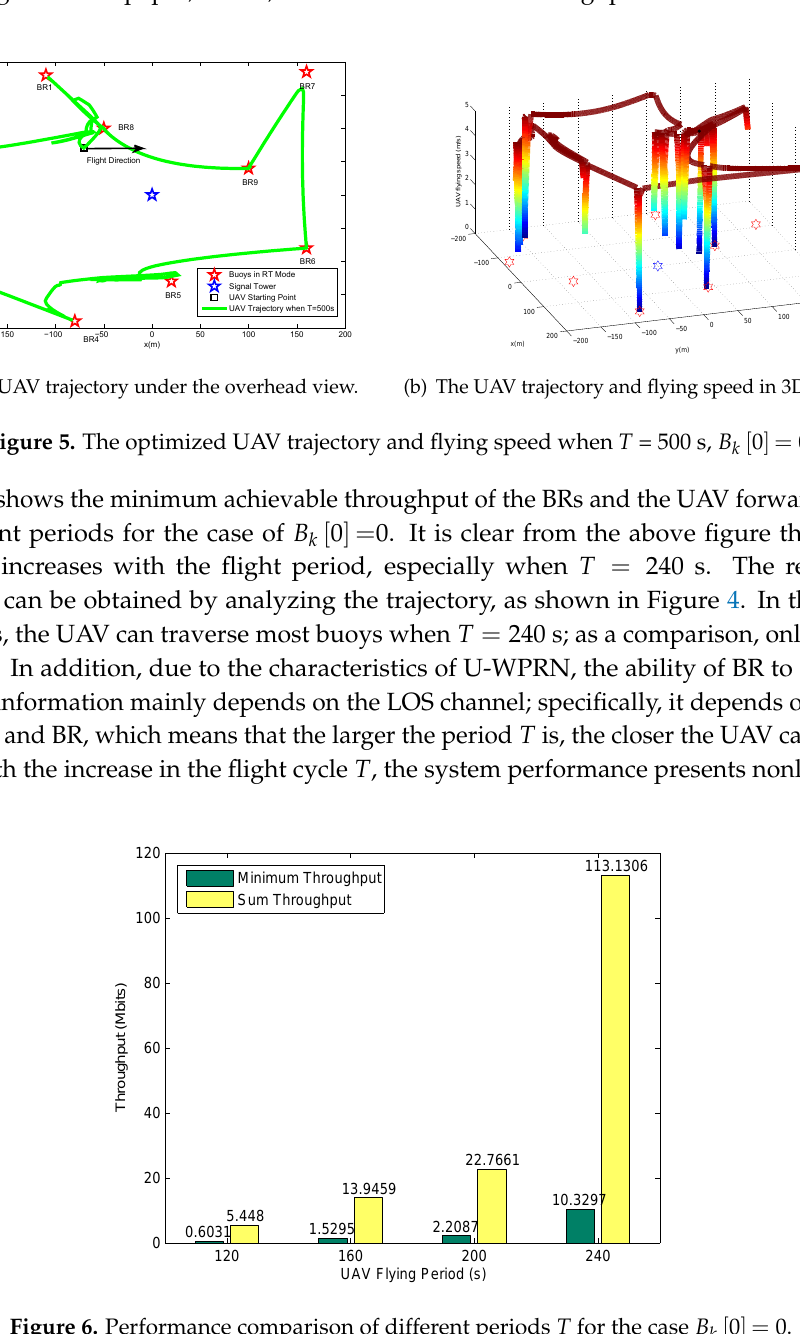
Figure 6. Performance comparison of different periods T for the case B k [ 0 ] =